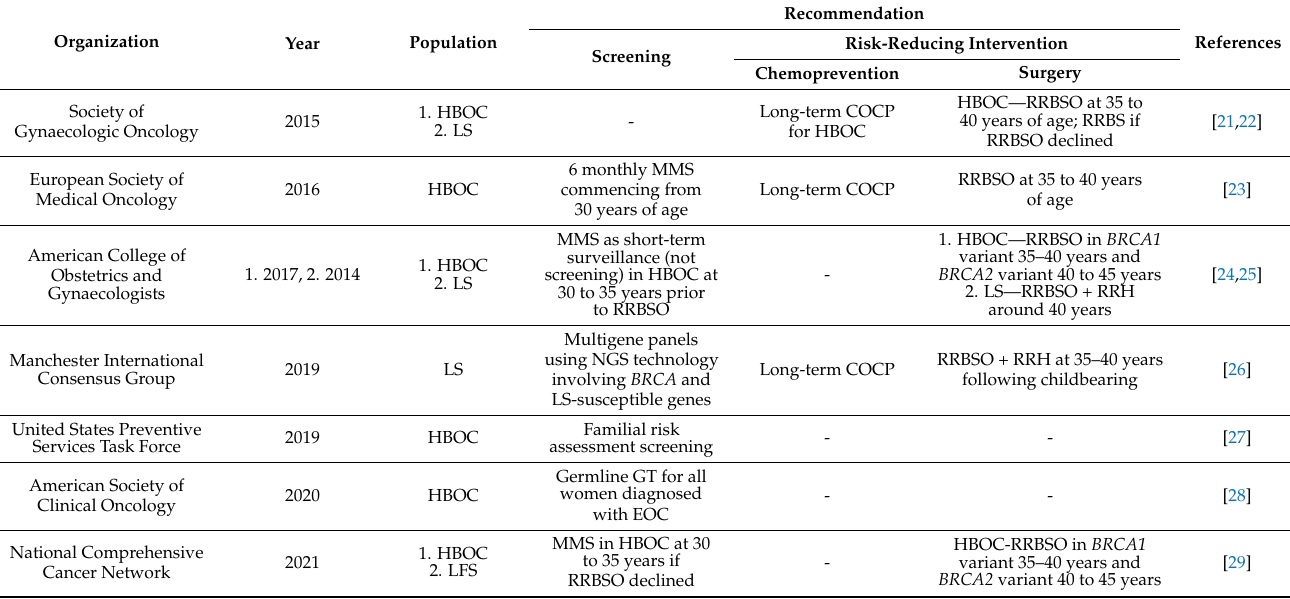
Table 1. Preventive strategies recommended by various international organisations for hereditary ovarian cancer